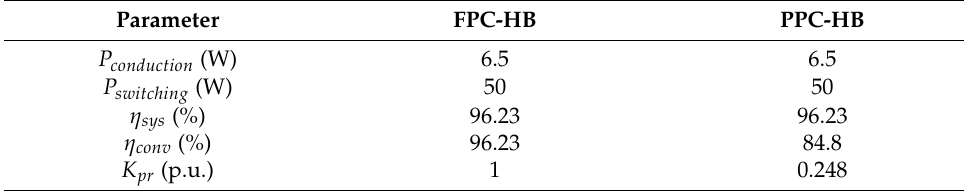
Table 3. Power losses, efficiency, and K pr results of the single-inductor topology. Parameter